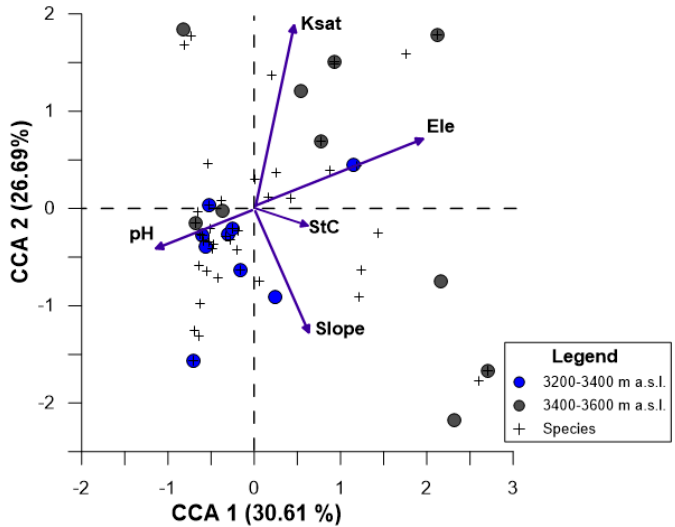
Figure 7. Canonical Correspondence Analysis (CCA), showing ordination of woody species richness and their plant cover (+), plot (circles) and attributes of pine plantation and their physical and chemical soil characteristics across an elevational range (arrows). Abbreviations are as follows: CD = canopy density, BA = basal area, Ksat = saturated hydraulic conductivity, SOC = soil organic carbon, StC = water content at saturation point, FC = water content at field capacity, AW = available water capacity, pH = potential hydrogen, Ele = elevation, BD = bulk density. The other variables that contributed little to the analysis are not visible here.